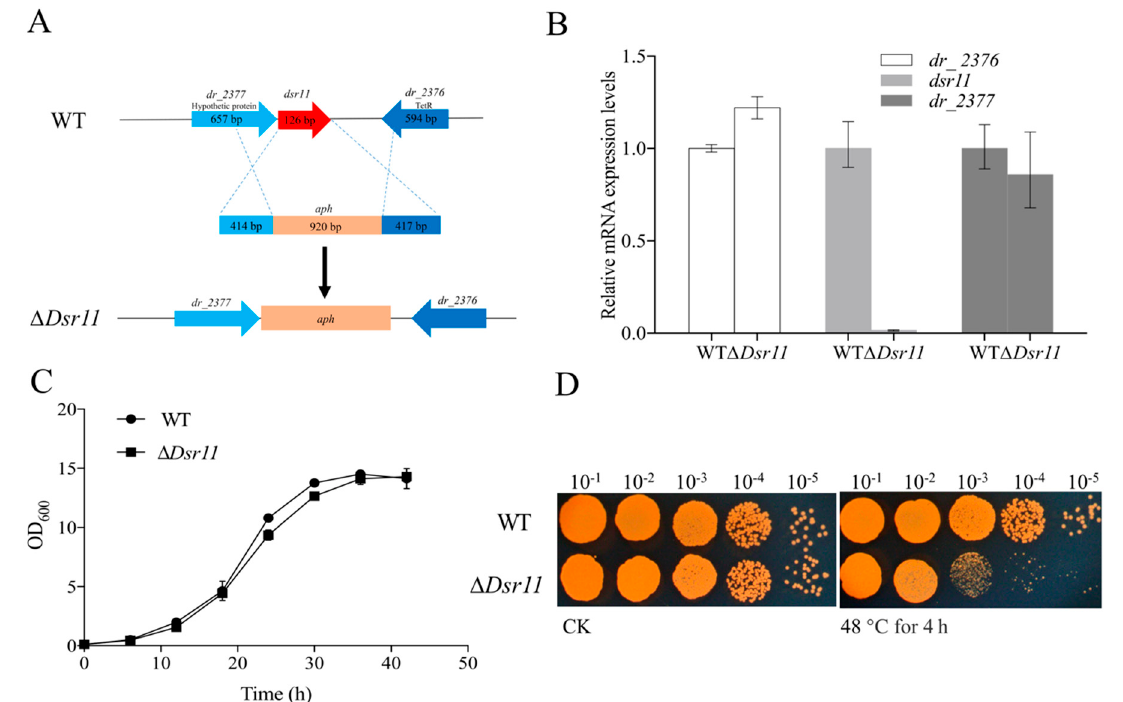
Figure 2. ( A ) The genomic location of dsr11 and construction of the dsr11 mutant. The dsr11 is shaded in red. Schematic representation of the mutant generated by replacing the dsr11 region with the kanamycin resistance gene aph . ( B ) Relative expression of dsr11 , the upstream gene ( dr_2376 ), and the downstream gene ( dr_2377 ) in ∆ Dsr11 compared to the WT under normal conditions. The relative levels of the transcripts are presented as the mean values ± standard deviation, calculated from three sets of independent experiments and normalized to levels in the WT strain. ( C ) Growth curves in TGY broth of WT and ∆ Dsr11 . The error bars represent the calculated standard deviation of the measurements of three biological replicates. ( D ) Viability of dsr11 knockout cells after exposure to 48 ◦ C. CK, untreated culture control. All experiments were performed three times.